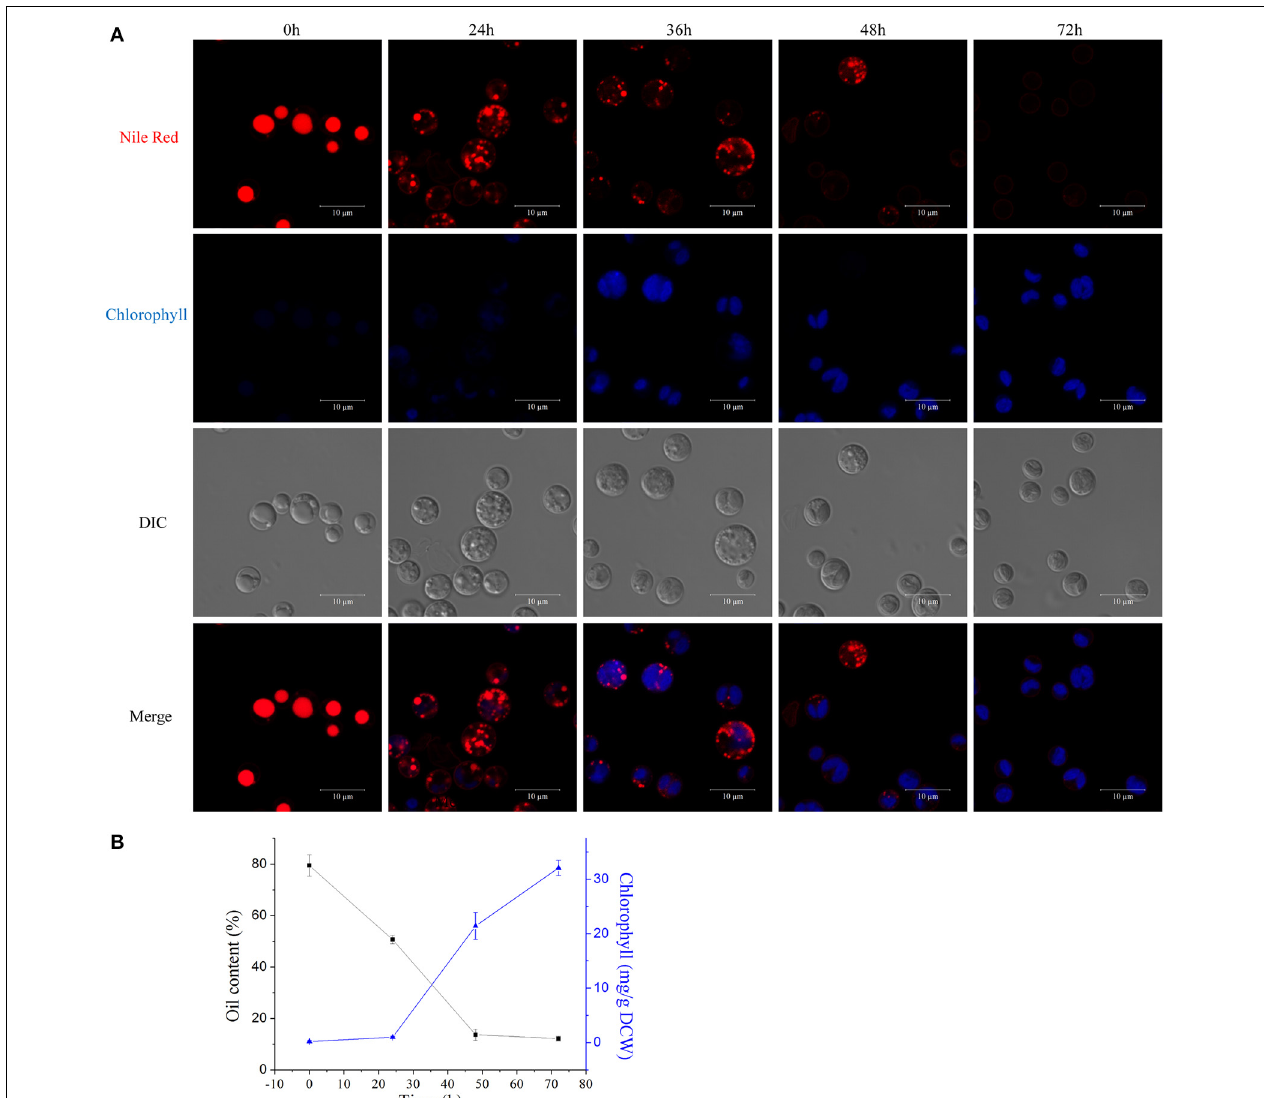
FIGURE 7 | Degradation of lipids and biogenesis of chloroplasts during the HA transition. (A) Confocal microscopy images of algal cells during the HA transition. Cells were cultivated in heterotrophic medium for 7 days and then transferred into autotrophic medium for 3 days. LDs were stained using